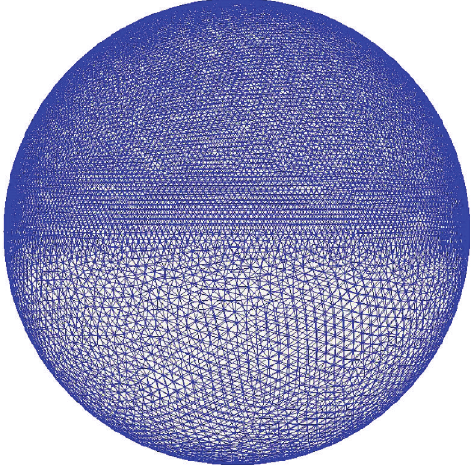
Figure 5: Mesh of a PEC sphere with radius 2𝜆 .